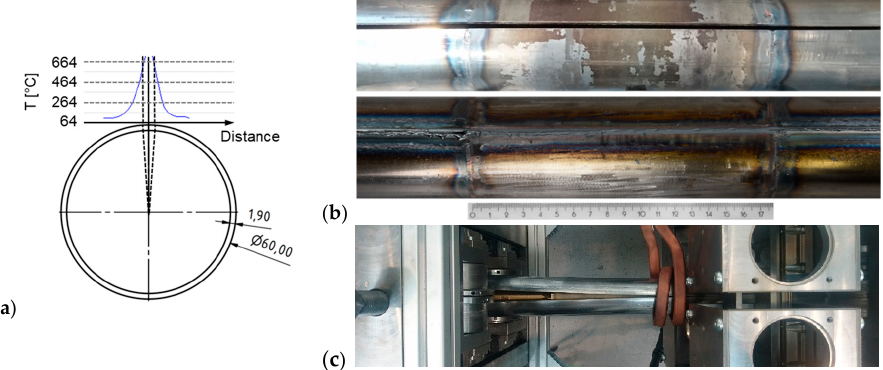
Figure 3. Sample geometry and temperature profile on the tube surface ( a ), prepared sample (top) and welded sample (bottom) with 42SiCr specimens in the middle and sacrificial segments on the left and right ( b ), welding setup ( c ).